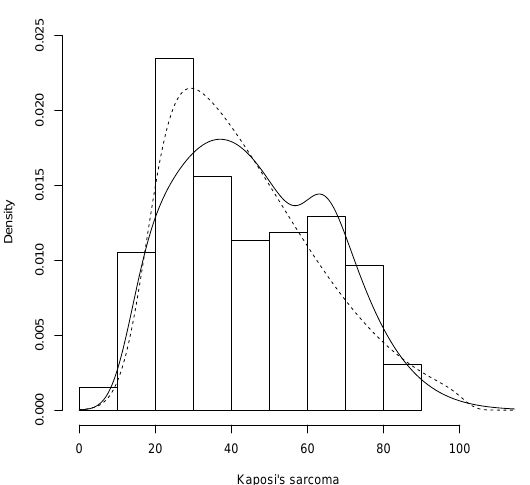
Figure 6. FSN distribution (dashed line) and GSN distribution (solid line) for the Kaposi’s sarcoma